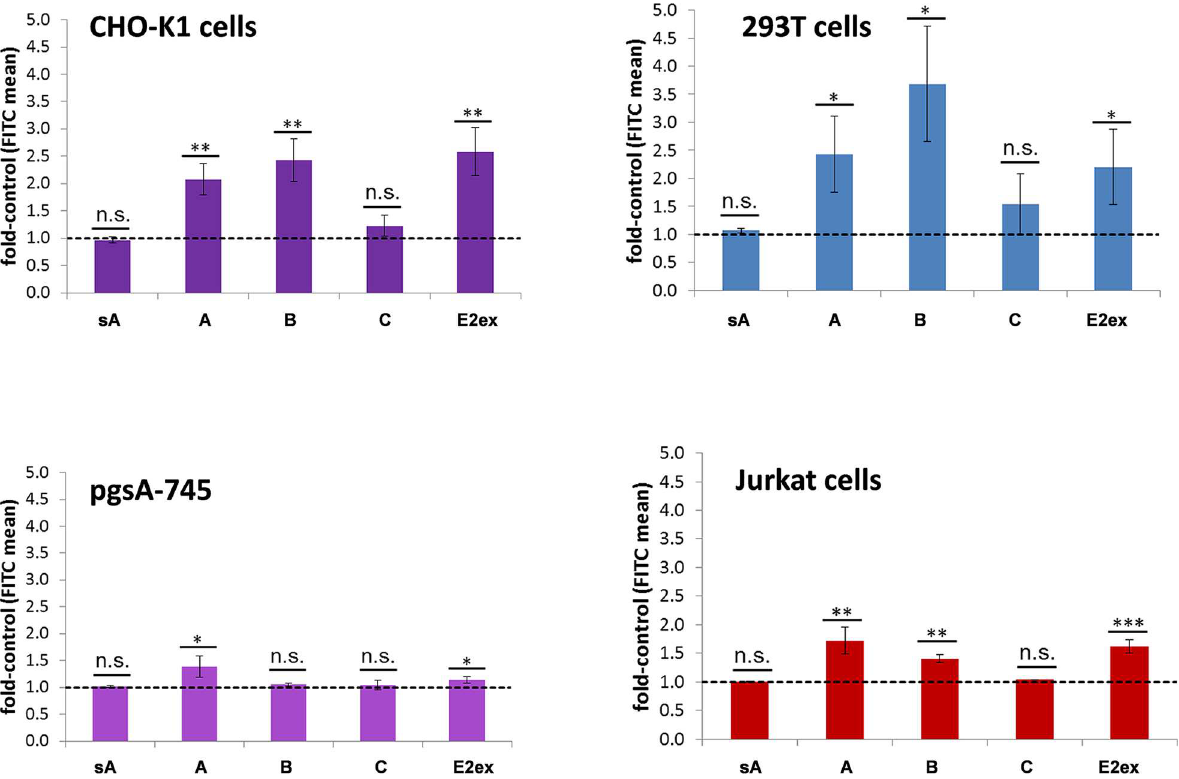
Fig 5. Binding of recombinant CHIKV E2 domains A, B, and C, and E2ex to CHO-K1 and pgsA-745cells. CHO-K1 (top) and pgsA- 745 (bottom) cells were incubatedwith 10 μ gof the indicated recombinant proteins.Bindingwas measuredby flow cytometry usingan anti- His-tag and an anti-mouseFITC conjugatedantibody.The results are shown relativeto the control (anti-His-tag andanti-mouseFITC antibodies alone).A valueof one represents the meanFITC valueof the controland is labeledby the dashedline. Valuesabovethis line indicatebinding.Data representthe averageof three independent experiments. * and ** indicatesignificantdifferencesto the recombinant protein-free controls. n.s. meansnot significant. * (P (cid:20) 0.05) and ** (P (cid:20) 0.01). Protein sA served as a negativecontrol [23].